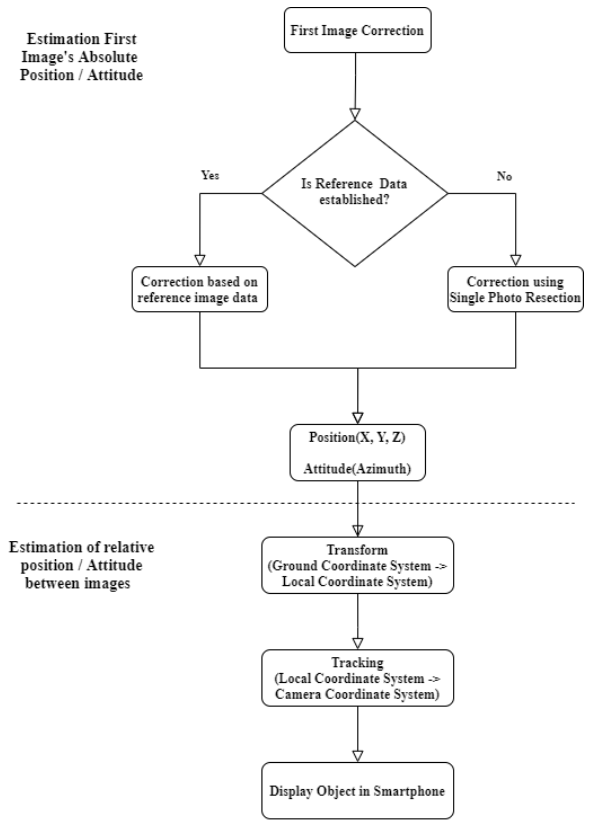
Figure 1. Process for visualizing objects based on ground coordinate system